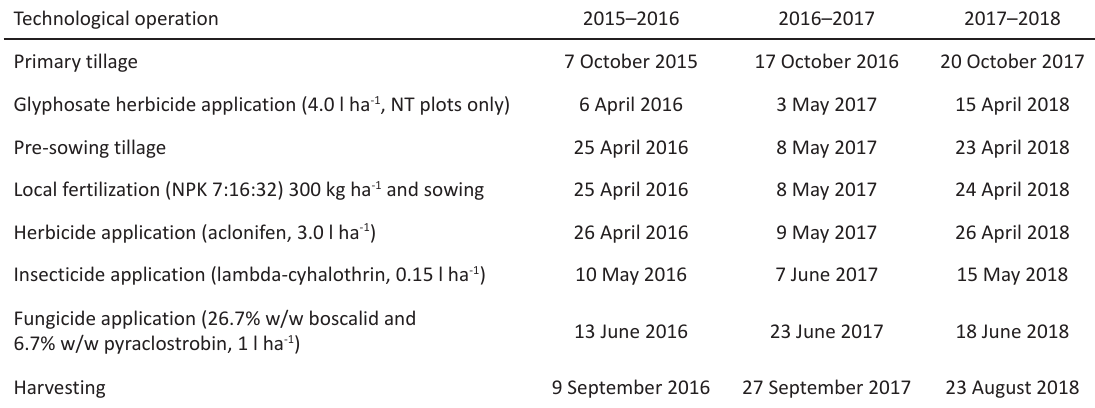
Table 4. Technological operations and timing in faba bean growing technology Technological